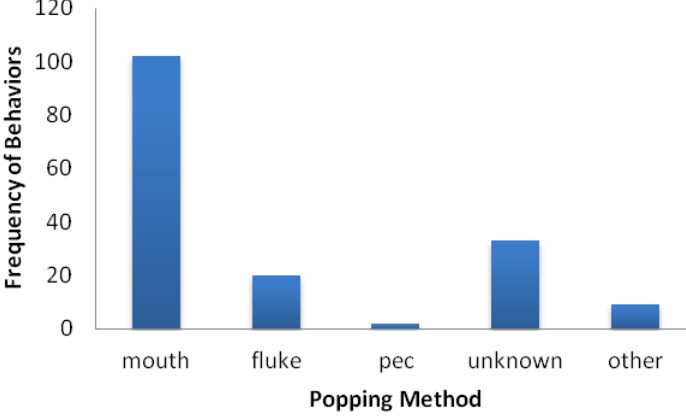
Figure 3. Body parts used to “pop” the bubble helix .